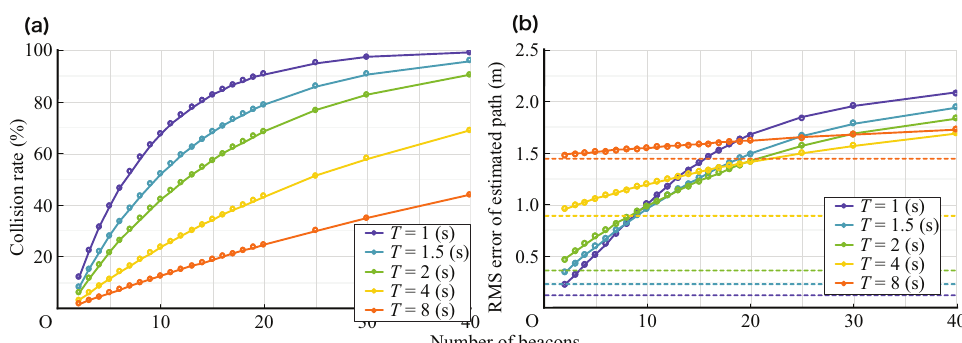
Figure 14. ( a ) Collision rate vs. the number of beacons ( J = 0.5). ( b ) Root mean squared error (RMSE) of the estimated path vs. the number of beacons ( J = 0.5). Dashed lines show the RMSE without collision for each T